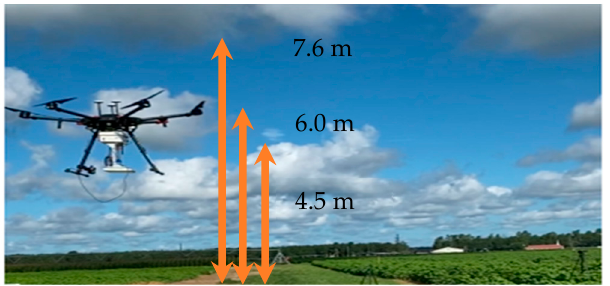
Figure 9. RFID-RM reader Small unmanned aircraft systems (sUAS) positioned directly over tags on the ground and then the aircraft was flown directly above those tags at three altitudes.